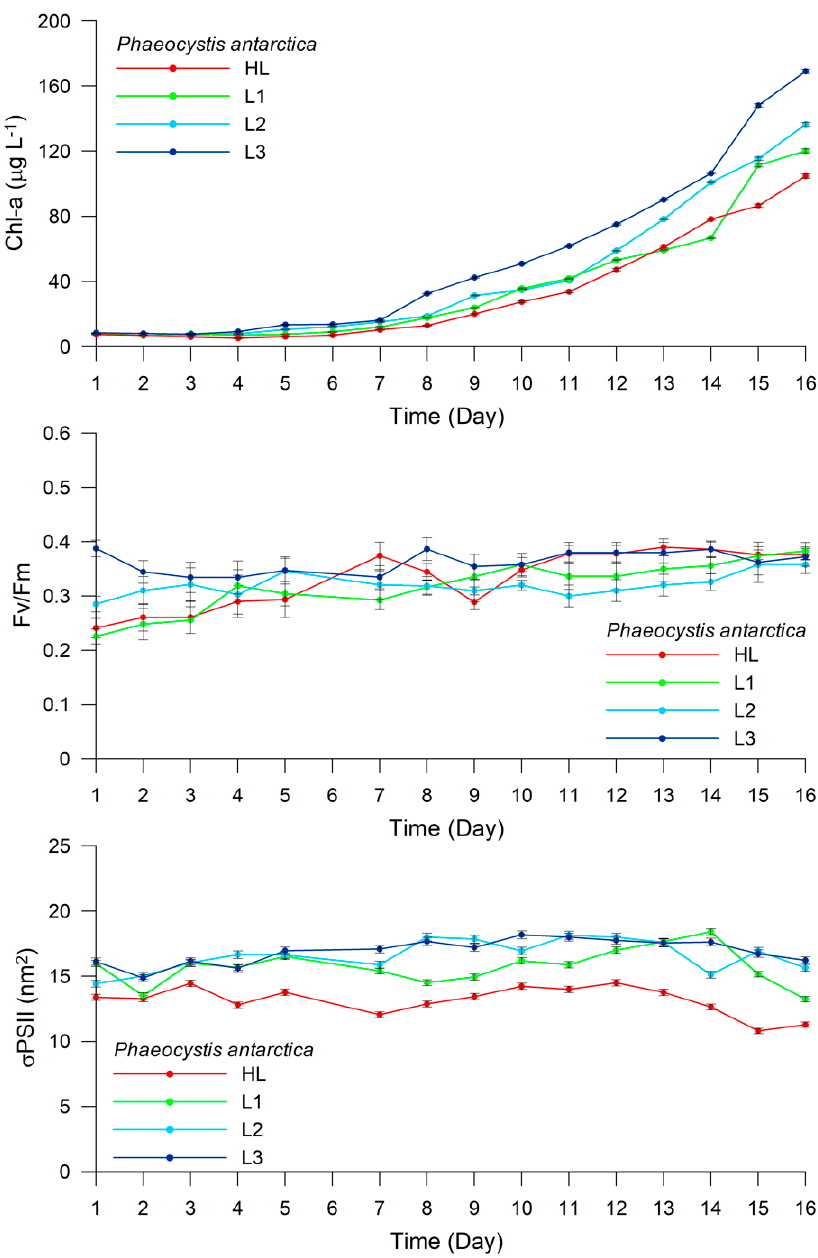
Figure 7. Experiment 2. Changes in Chl-a concentration ( µ g L − 1 ), Fv / Fm, and σ PSII (nm 2 ) in Phaeocystis antarctica under different light intensities (HL, L1, L2, and L3).